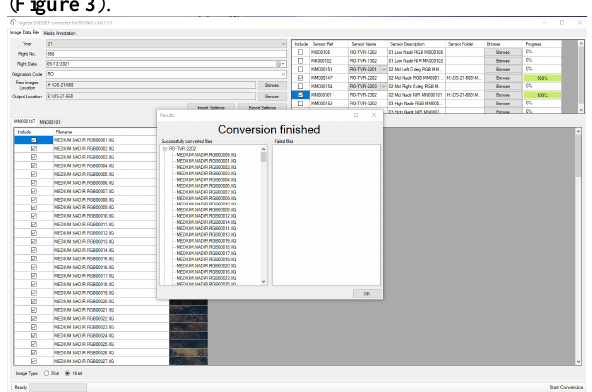
Figure 3 . Romanian convertor used in Open Skies missions All the resulted OSDDEF images are then duplicated and transferred on media storages to be shared between the mission implied nations using Beyond Compare software and will be furthermore analyzed by IMINT (Imagery INTeligence) specialists from the observation state.